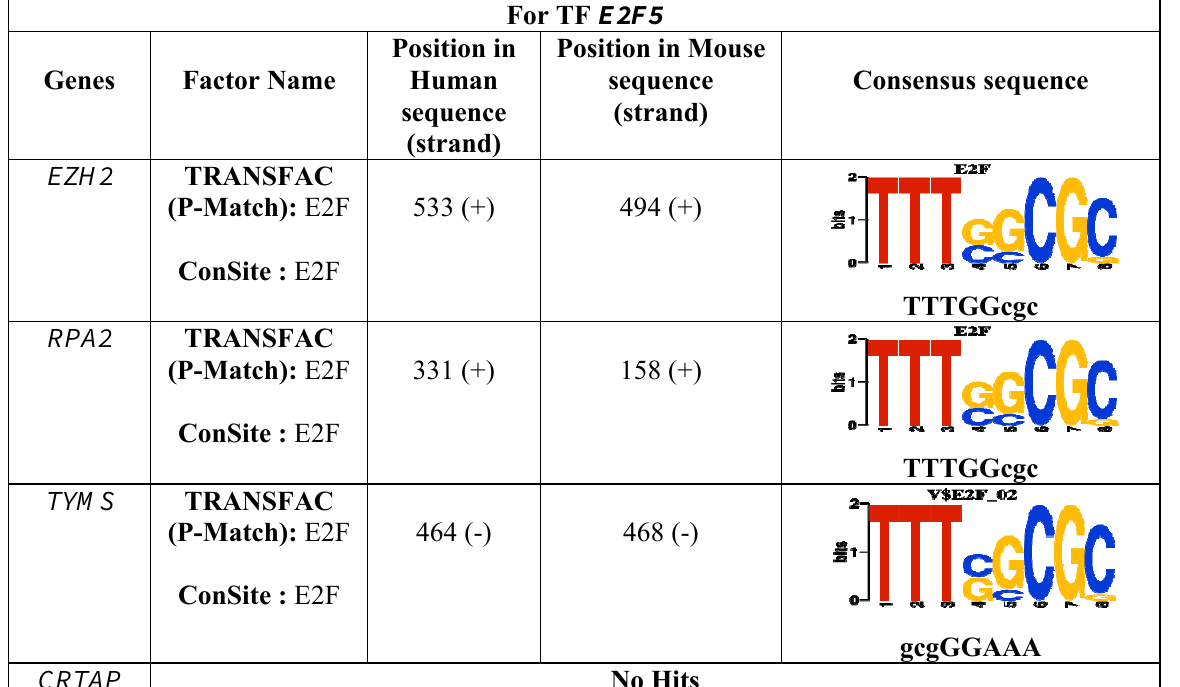
Table 3: The list of identified binding sites for four TFs. The consensus sequence logo plots for available PWM’s in TRANSFAC are shown. Results were validated using both TRANSFAC and